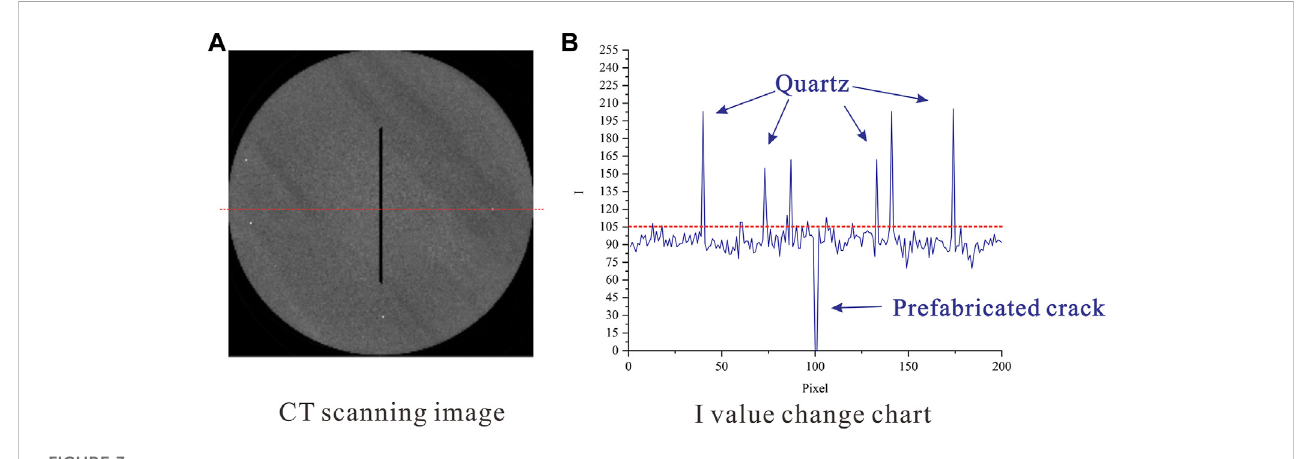
FIGURE 3 I-value change curve. (A) CT scanning image. (B) I value change